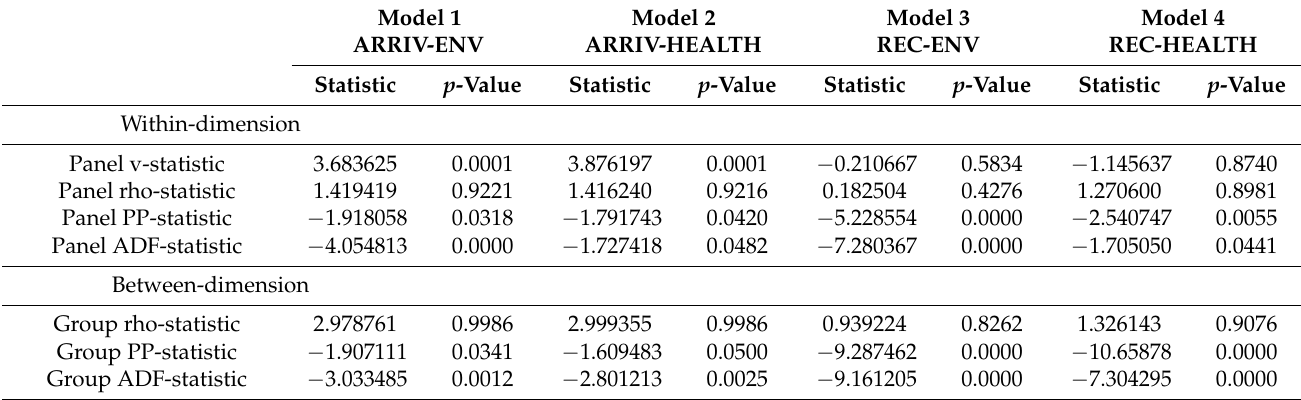
Table 5. Panel cointegration test